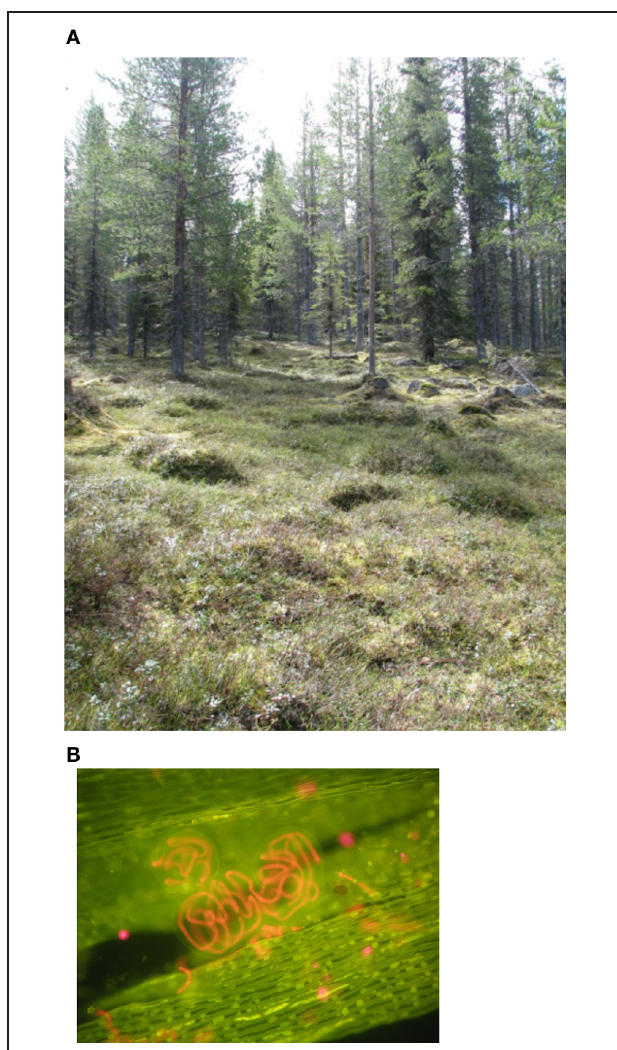
FIGURE 2 | (A) A late-succession boreal forest site in Northern Sweden with an open canopy and a moss-dominated understory. Mosses, in particular feather mosses like Pleurozium schreberi and Hylocomium splendens , cover 70–100% of the ground in boreal forests. Photo by K. Rousk. (B) A section of a Pleurozium schreberi -leaf at × 100 magnification under an UV-fluorescence microscope. Coiled chains of Nostoc spp. are seen in bright red. The moss-cyanobacteria association is assumed to be mutualistic, however, no attempts have been made so far to identify the relationship moss and cyanobacteria share. Photo by K.